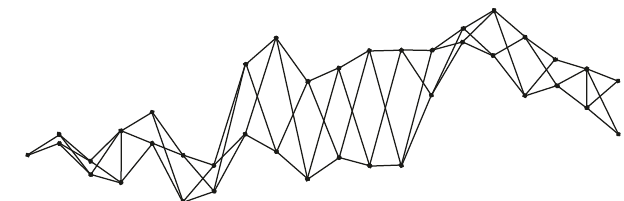
Figure 17: Resulting graph from the process of calculating the distances of the segments of signals O1 and O2.